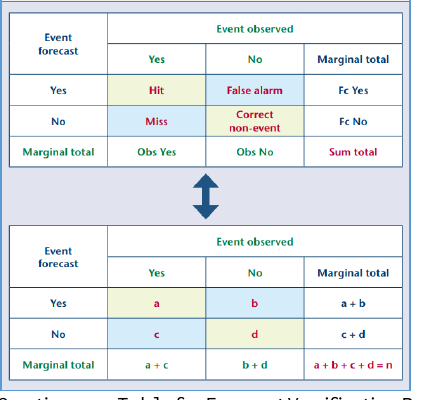
Figure 3. Contingency Table for Forecast Verification Parameters Estimation (Source: Mariani and Casaioli, 2008)